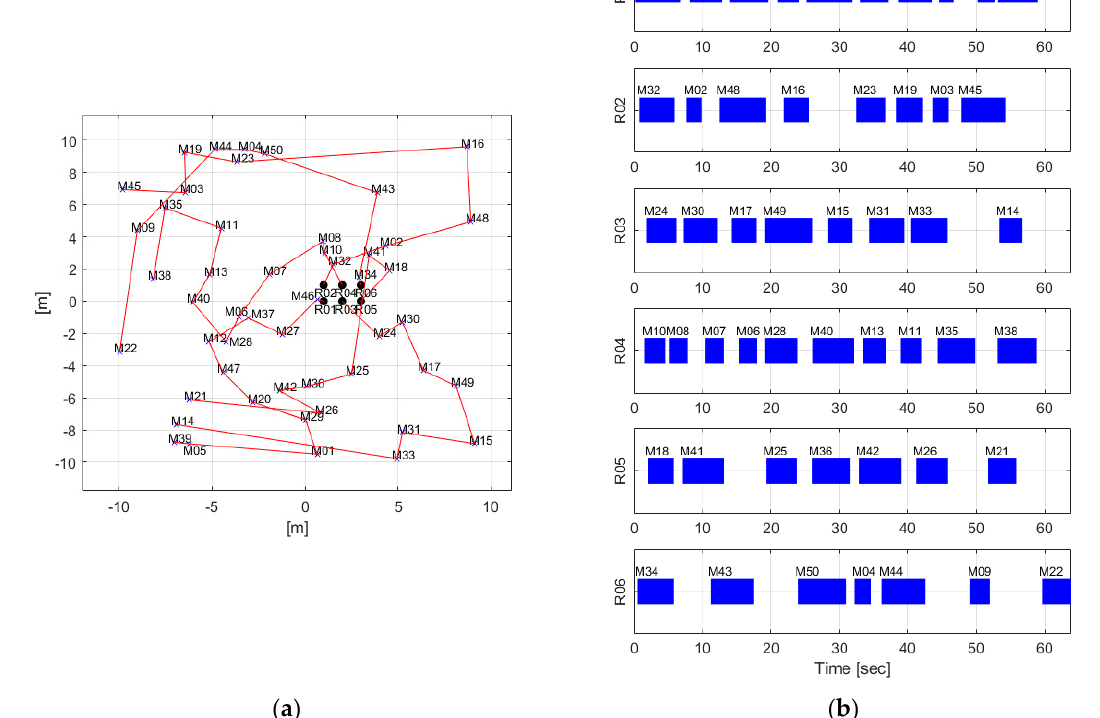
Figure 7. The results for huge case using CBBA: ( a ) 2D situation map; ( b ) timetable.